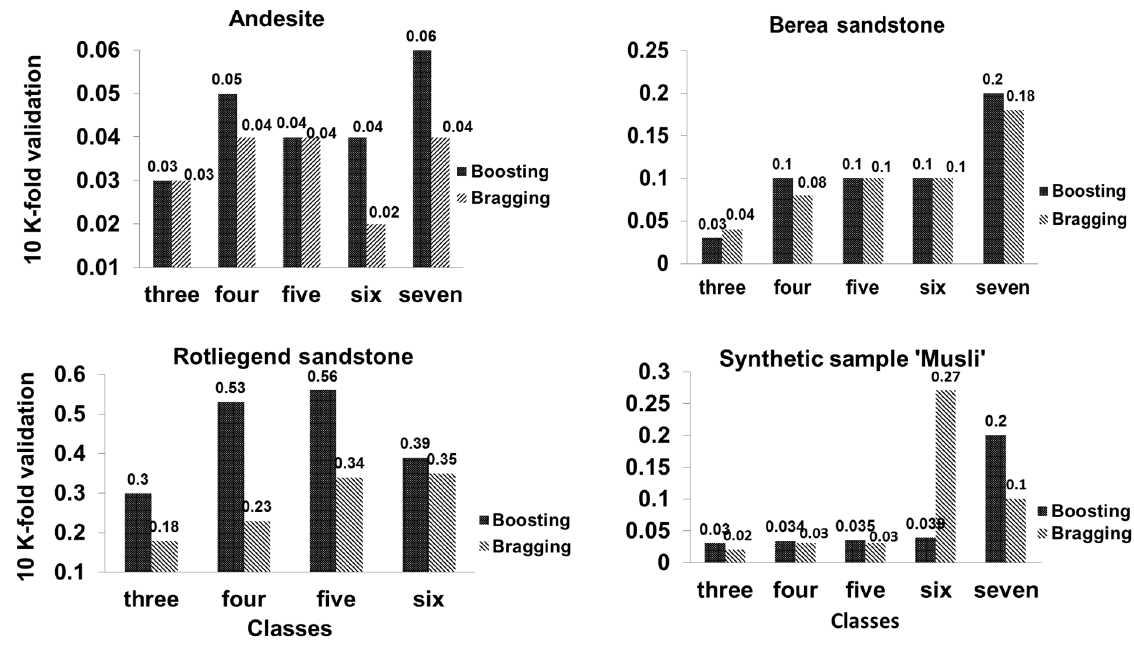
Figure 9. Accuracy of ensemble classifiers boosting and bragging calculated using 10 K-fold validation for respective